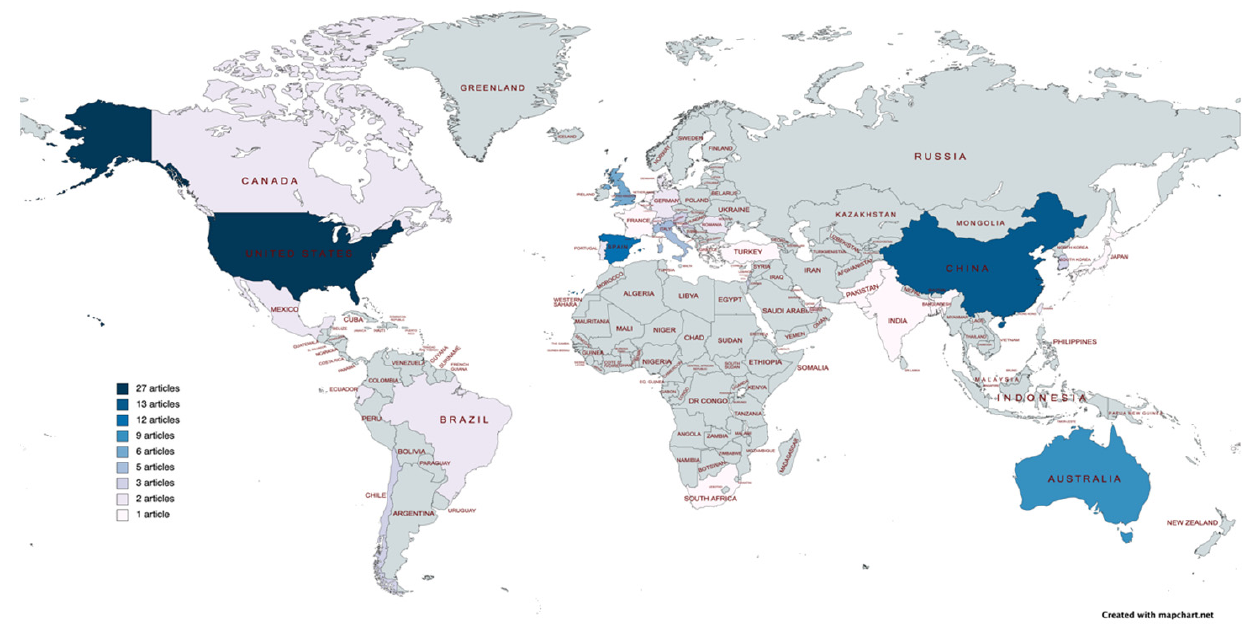
Figure 5. Number of articles published by country ( ≥ 1 article).